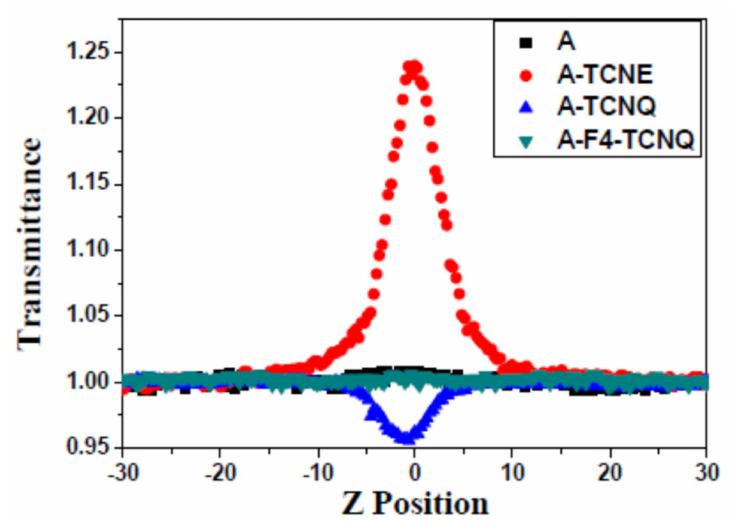
Figure 4. Z-scan results of the compounds in CH 2 Cl 2 .